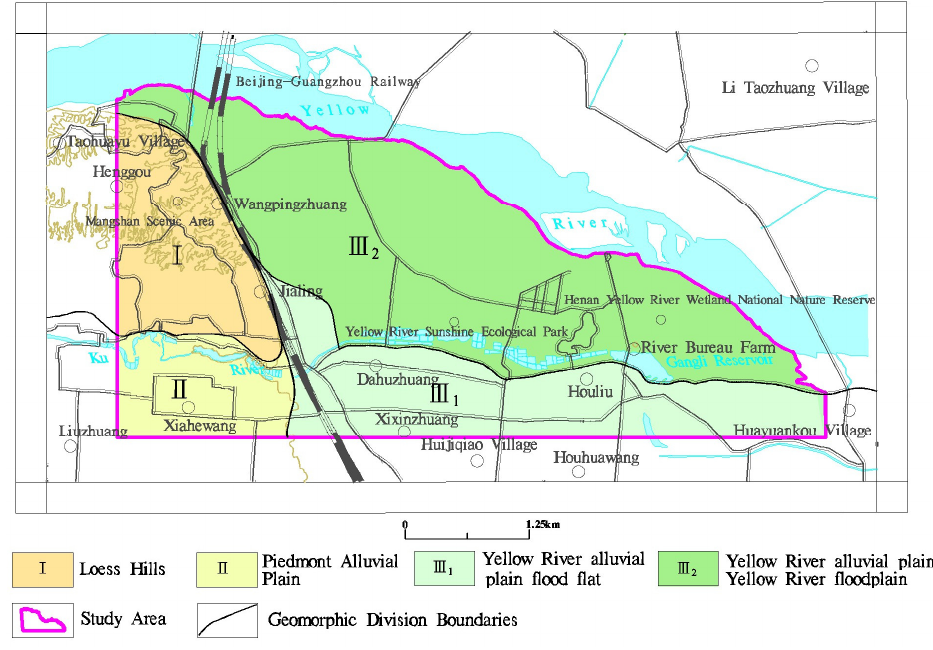
Figure 1. Geomorphic map of the study area.